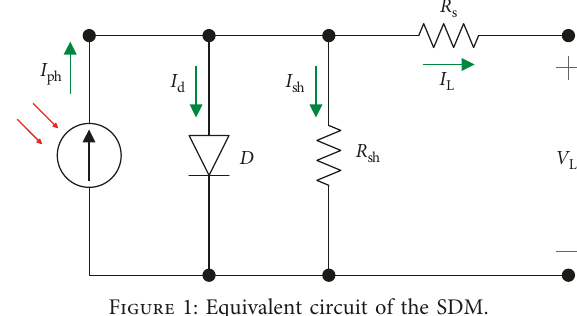
Figure 1: Equivalent circuit of the SDM.